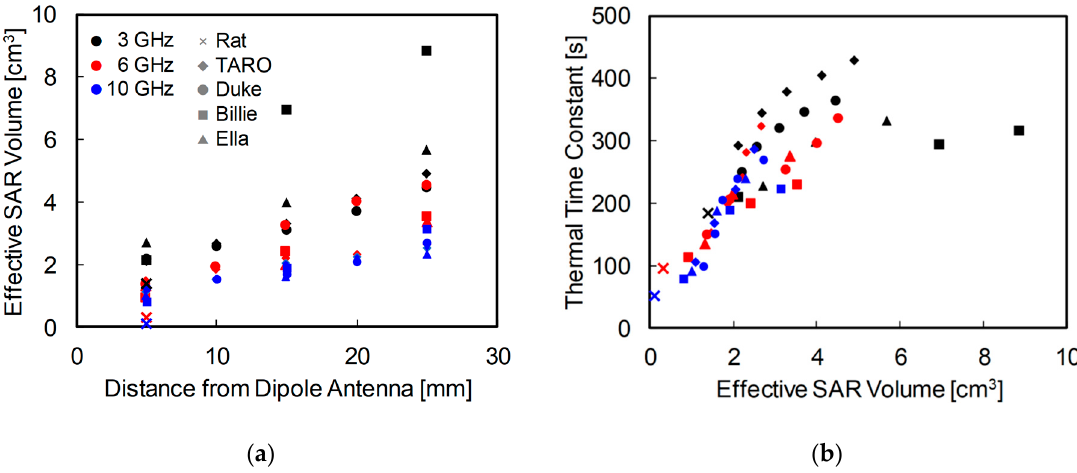
Figure 8. ( a ) Effective SAR volume for each exposure scenario; and ( b ) relationship between the thermal time constant of skin and effective SAR volume in rat and human models. The output power of the antenna was adjusted so that the peak SAR averaged over 10-g tissue was 10 W/kg.